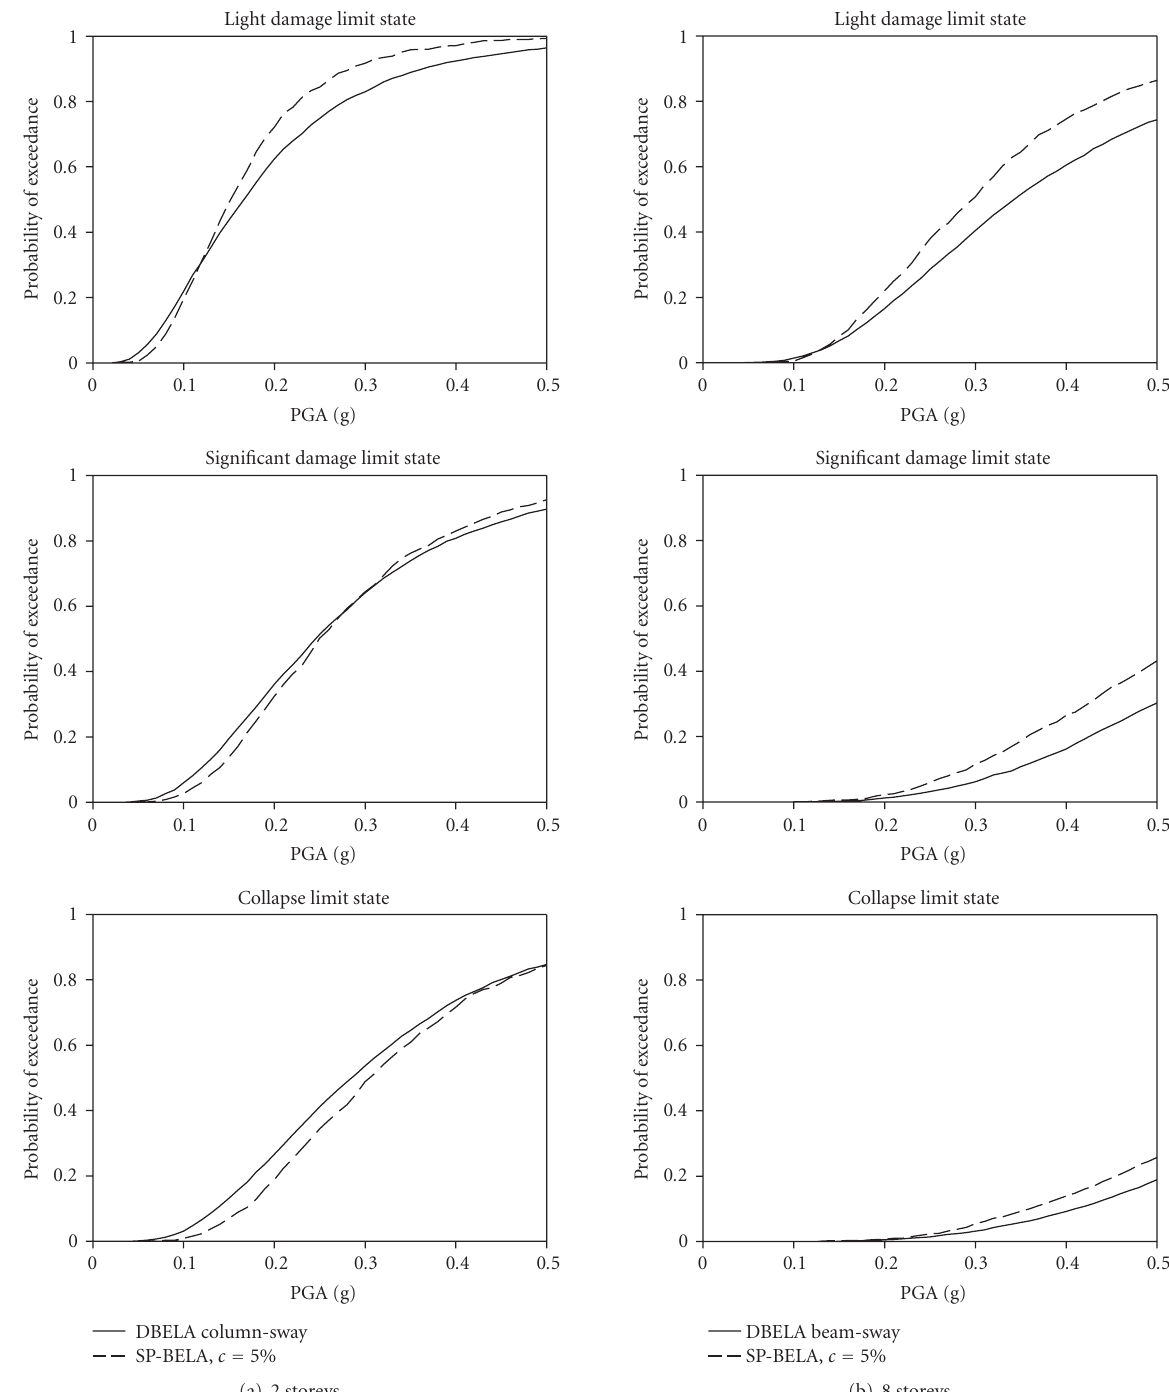
Figure 17: Vulnerability curves calculated with DBELA and SP-BELA for (a) 2-storey and (b) 8-storey buildings.